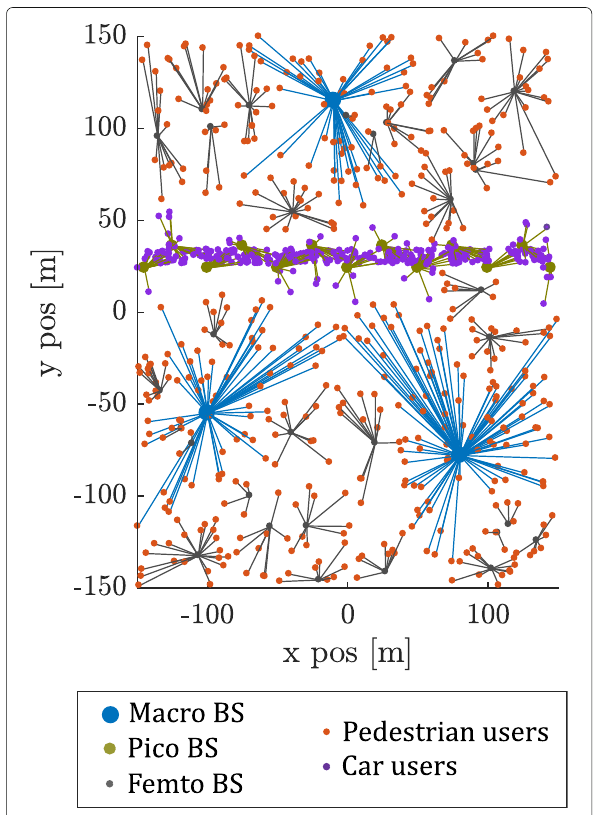
Fig. 7 BS-user association based on the maximum received power. This figure shows an example of a heterogeneous network consisting of various BS and user types. Colored lines denote the BS-user association, each color denoting a BS type. The implemented scenario represents an urban environment with one main highway going through the center, with dedicated pico cells for this